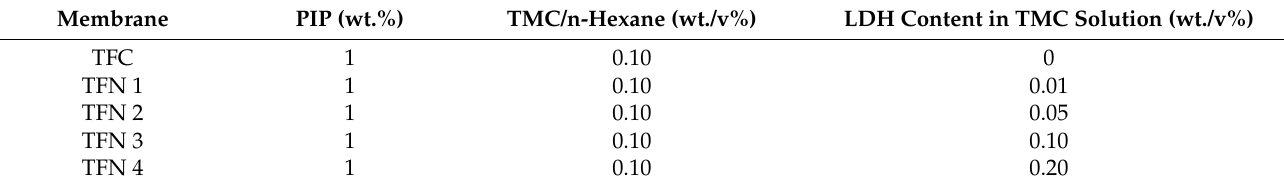
Table 1. The composition of the produced membranes.